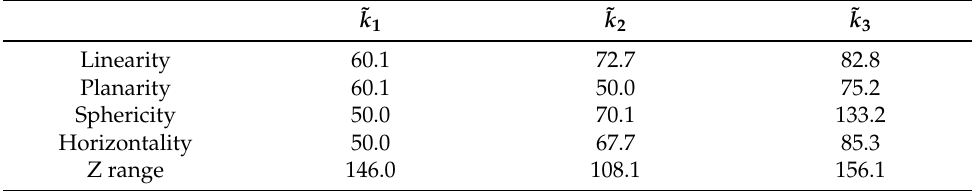
Table 4. Most frequent values of scales selected using Algorithm